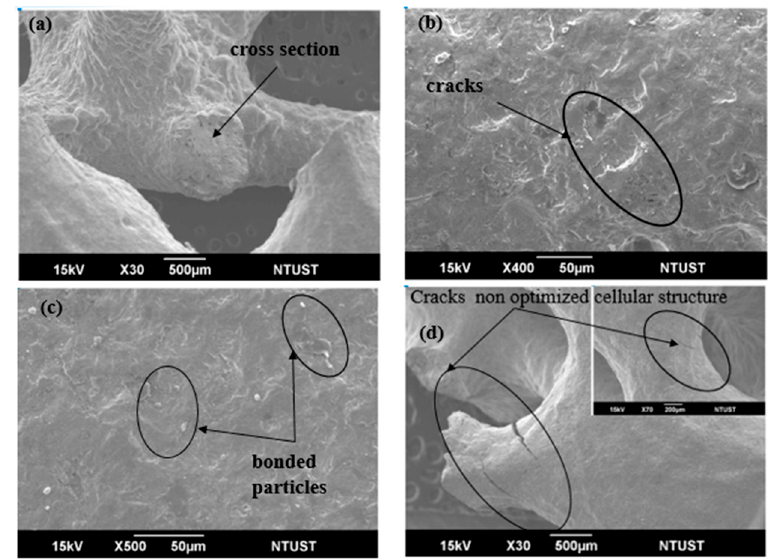
Figure 8. SEM images of ( a ) the cross-section cellular implant with vintiles cell size of 4 × 4 × 4 mm ( b ) the cracks on the surface of beam, ( c ) bonded particles on the surfaces of the beams, and ( d ) cracks on non-optimized surface.